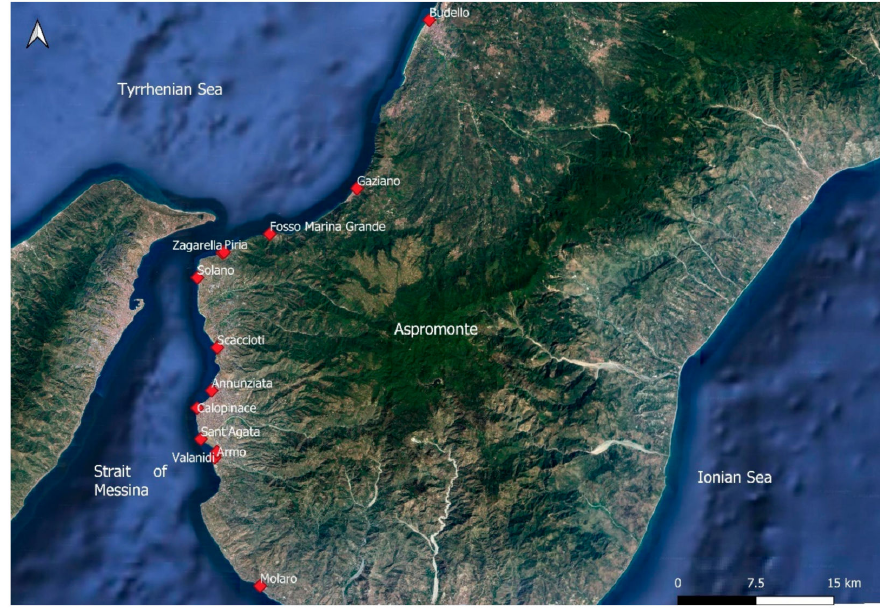
Figure 2. The analyzed